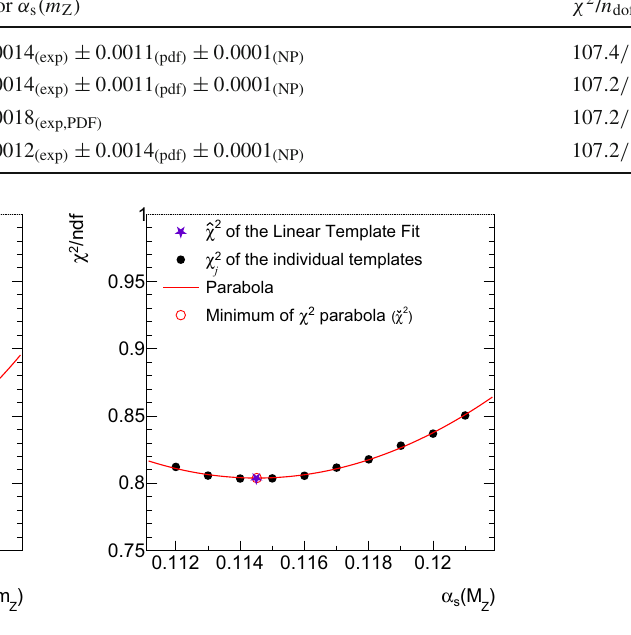
values of the Linear Template Fit with normally distributed uncertain- ties. Right: χ 2 / n dof values of the linear template with log-normally dis- tributed uncertainties. Note that the left figure uses the PDF set MSTW for the NLO predictions with a varying α s ( m Z ) value, whereas the right one uses the PDF set dof